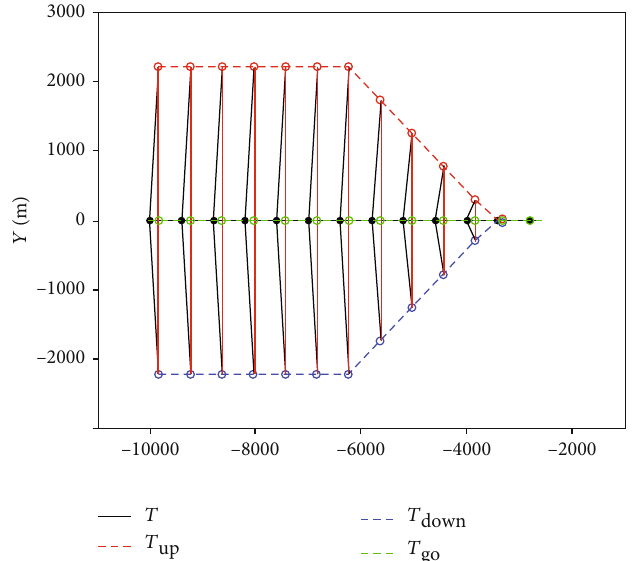
Figure 6: Virtual targets with constant velocity